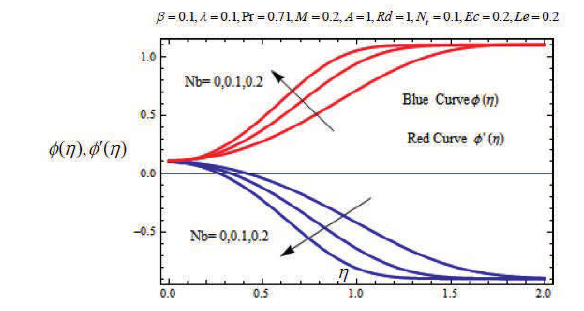
Fig. 17: Variation ϕ ( η ) ϕ (cid:3) ( η ) with η for several values of Brownian motion parameter N b .